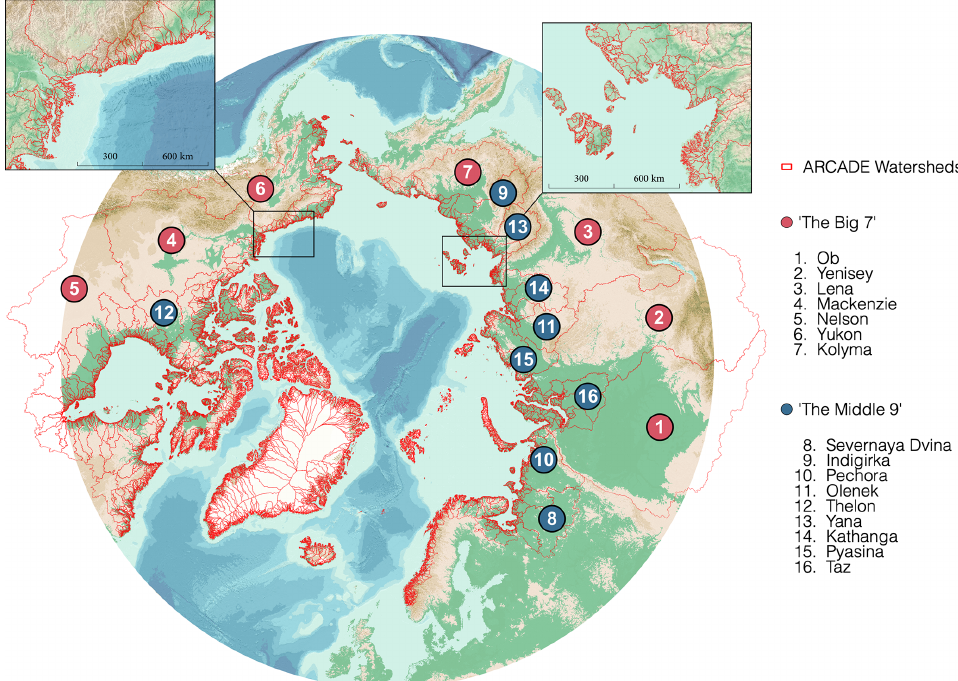
Figure 1. Circumpolar map of all ARCADE watersheds, 1km 2 and larger, Strahler order 5 and higher, at 90m resolution with insets of the Southern Beaufort Sea region (upper left) and the Laptev Sea coast, including the New Siberian Islands (upper right). (Background map: International Bathymetric Chart of the Arctic Ocean V4.0 (IBCAO) (Jakobsson et al.,